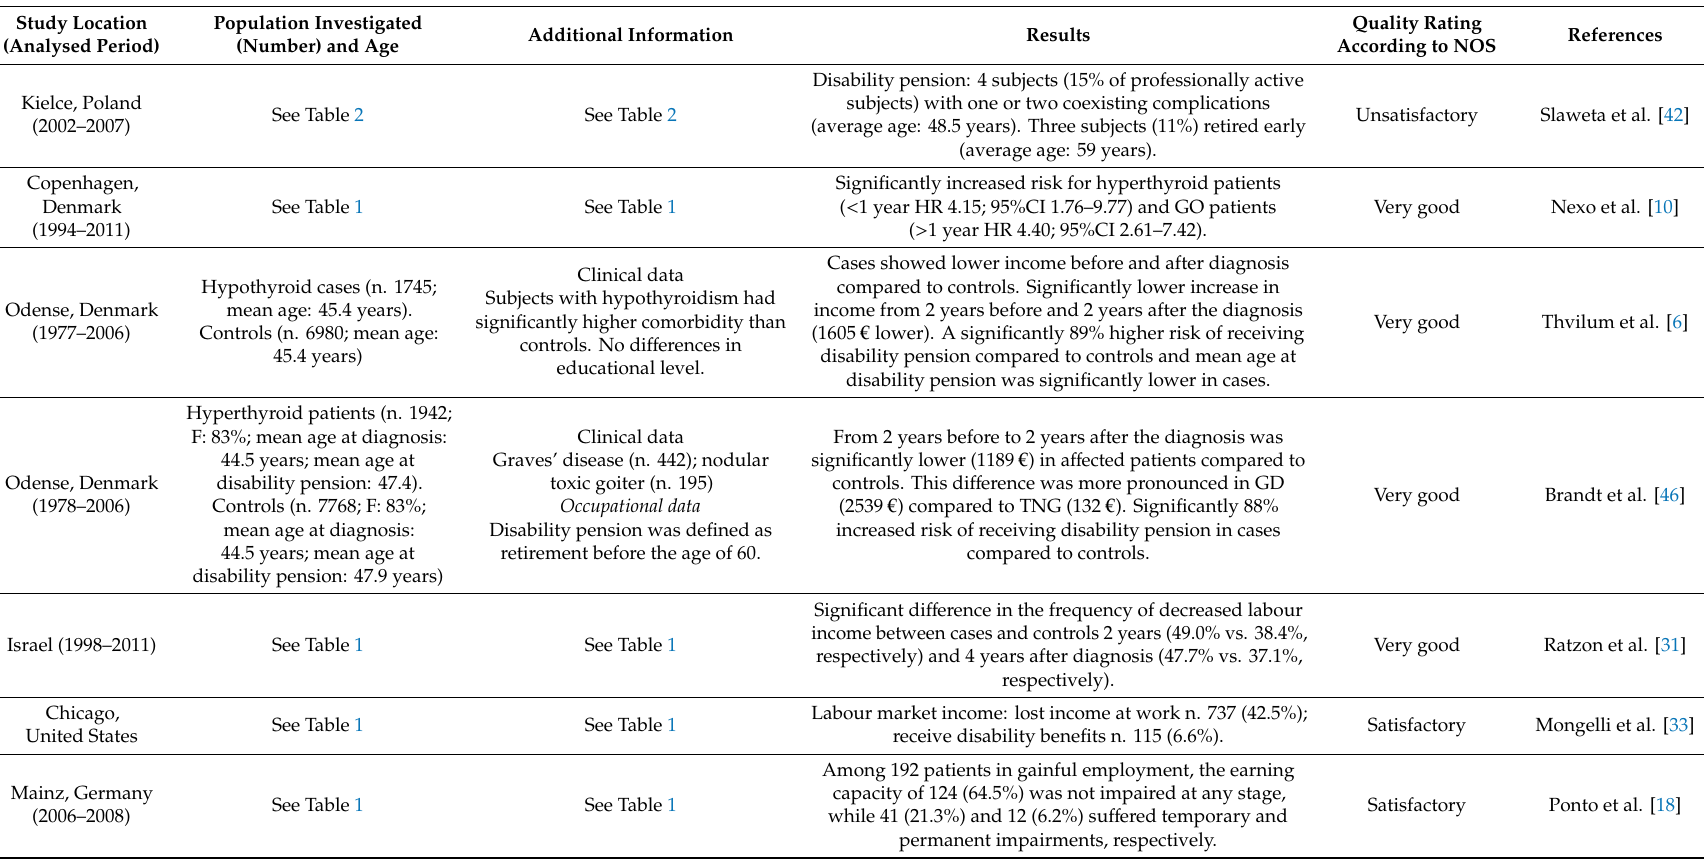
Table 4. Summary of the studies addressing the impact of thyroid disease on labor market income and disability